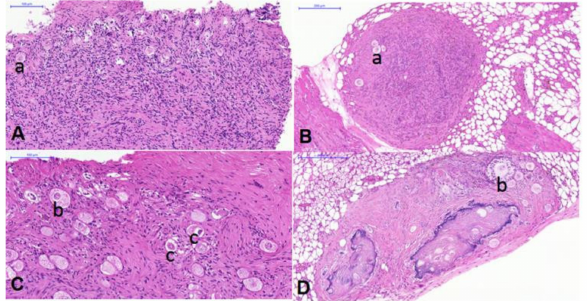
Figure 1. Representative images of ovarian cortex without exposure ( A , B ) and with exposure to chemotherapy ( C , D , Case 10, CED 20840 mg/m 2 , DIE 225 mg/m 2 ), before ( A , C ) and after ( B , D ) 22 weeks of xenotransplantation; ( a ) primordial; ( b ) secondary follicle; ( c ) atretic follicle. No difference in graft recovery was detected between samples from patients with and